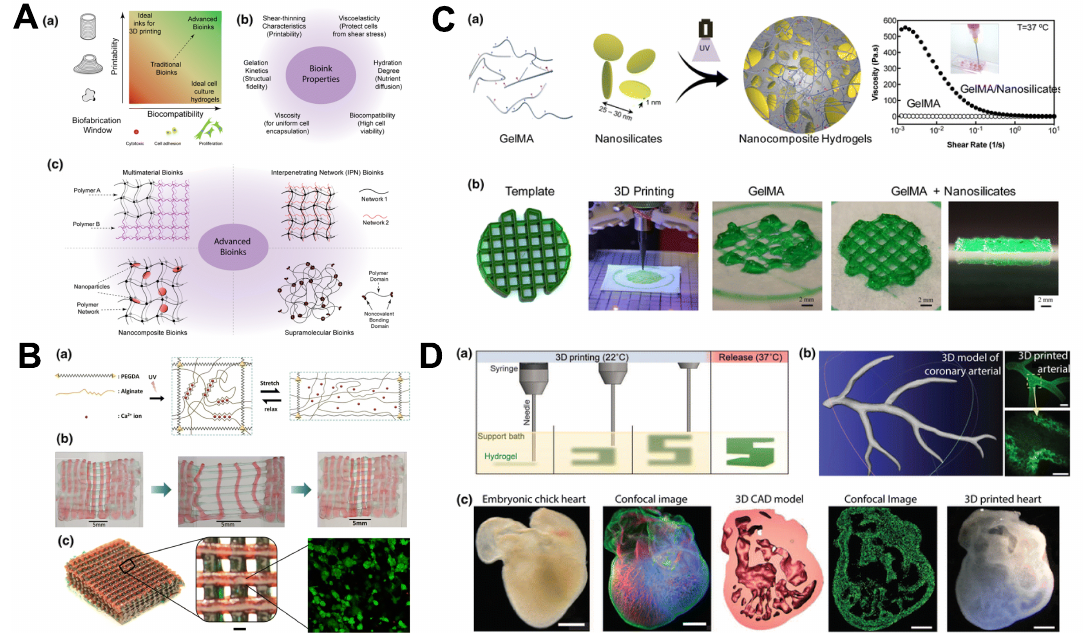
Figure 13. Hydrogel-based 3D printing for artificial organs, and soft biosensors. ( A ) Advanced bioinks for 3D printing, ( B ) interpenetrating network (IPN) bioinks for 3D printing, ( C )